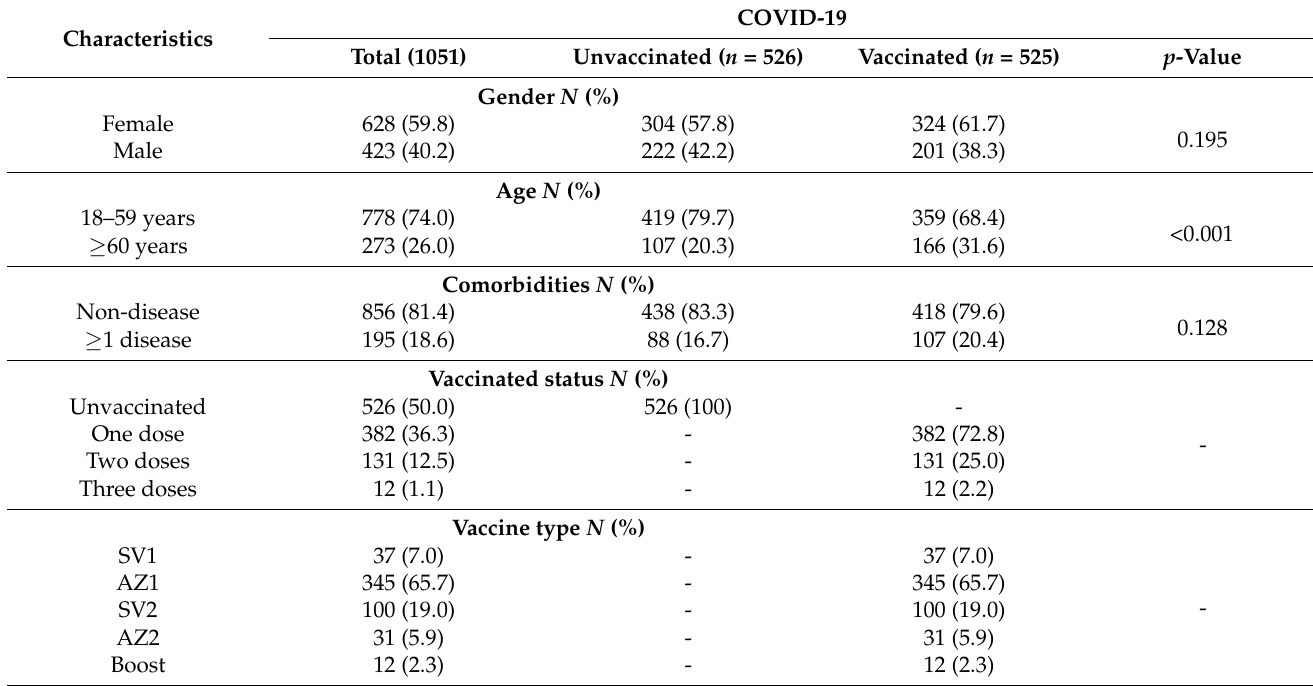
Table 1. Characteristics of COVID-19-positive cases in this study.